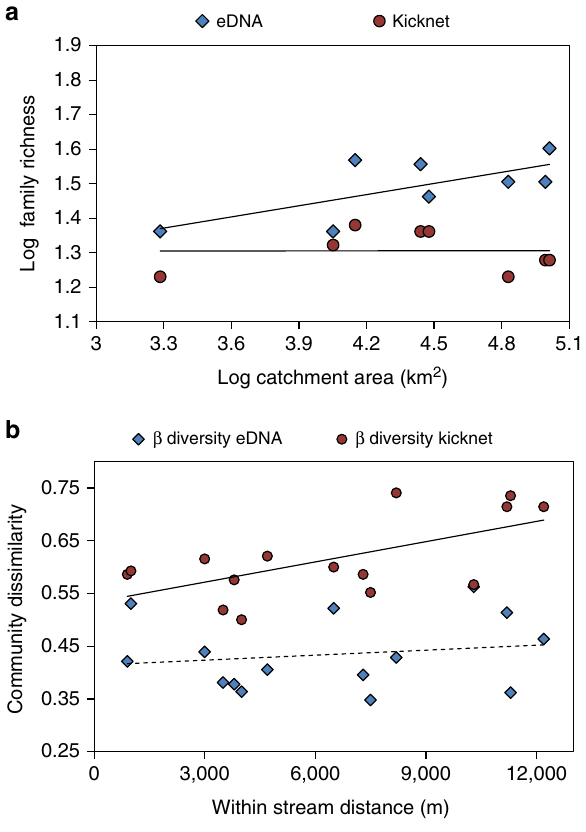
Figure 4 | Difference of benthic macroinvertebrate family richness and community dissimilarity estimated between the environmental DNA and kicknet sampling. ( a ) a -diversity measured at each site and log 10 transformed taxon–area relationship for eDNA and kicknet samples. Slopes of line and the y intercept are significantly higher for eDNA compared with kicknet ( P o 0.0001, P ¼ 0.0002, respectively), indicating that eDNA samples a greater amount of diversity over a greater area compared with kicknets. ( b ) Correlation of community dissimilarity with along-stream geographic distances between sample sites. Solid line for kicknet b -diversity indicates a significant positive relationship with stream distance ( P ¼ 0.005). Dashed line for eDNA b -diversity indicates no significant relationship with distance ( P ¼